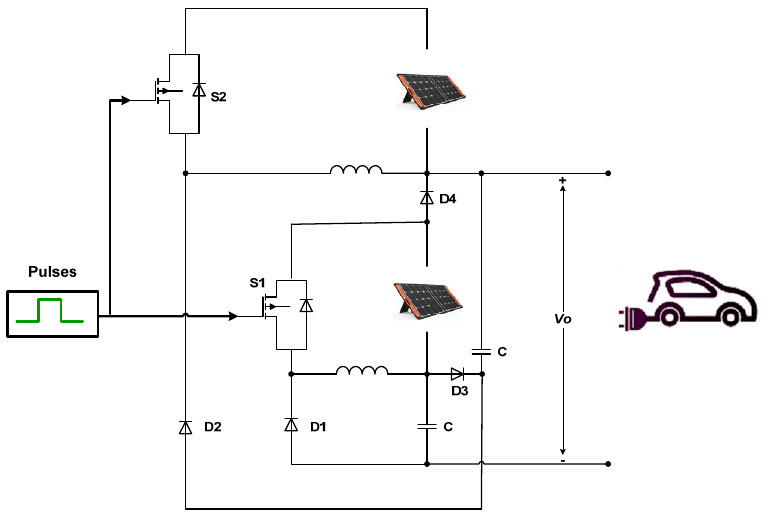
Figure 6. A suggested use for using the proposed converter as a charger for electric vehicles’